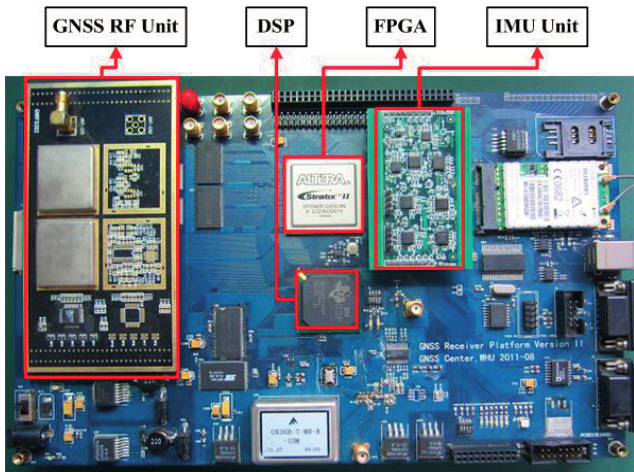
Figure 10. Hardware platform of a GNSS/INS deeply-coupled system. DSP means digital signal processor.